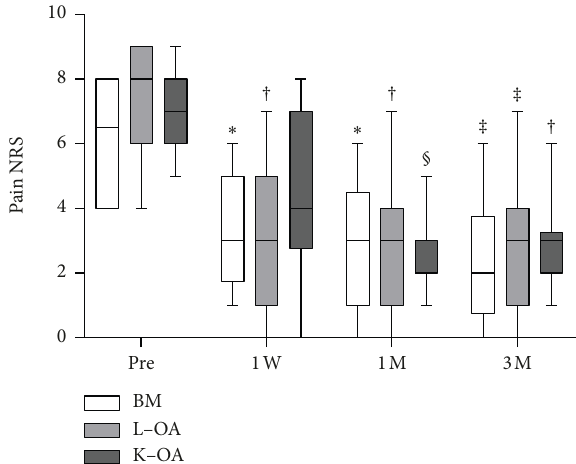
Figure 3: Pain NRS scores of patients at various time points. White, light gray, and gray bars indicate pain NRS scores of patients with BM ( n � 10), L-OA ( n � 11), and K-OA ( n � 18), respectively. ∗ p < 0 . 05 versus pretreatment scores; † p < 0 . 005 versus pre- treatment scores; ‡ p < 0 . 0005 versus pretreatment scores; § p < 0 . 0001 versus pretreatment scores. BM, bone metastasis; L- OA, lumbar facet joint osteoarthritis; K-OA, knee osteoarthritis; NRS, numerical rating scale; Pre, pretreatment; W, week; M, month.